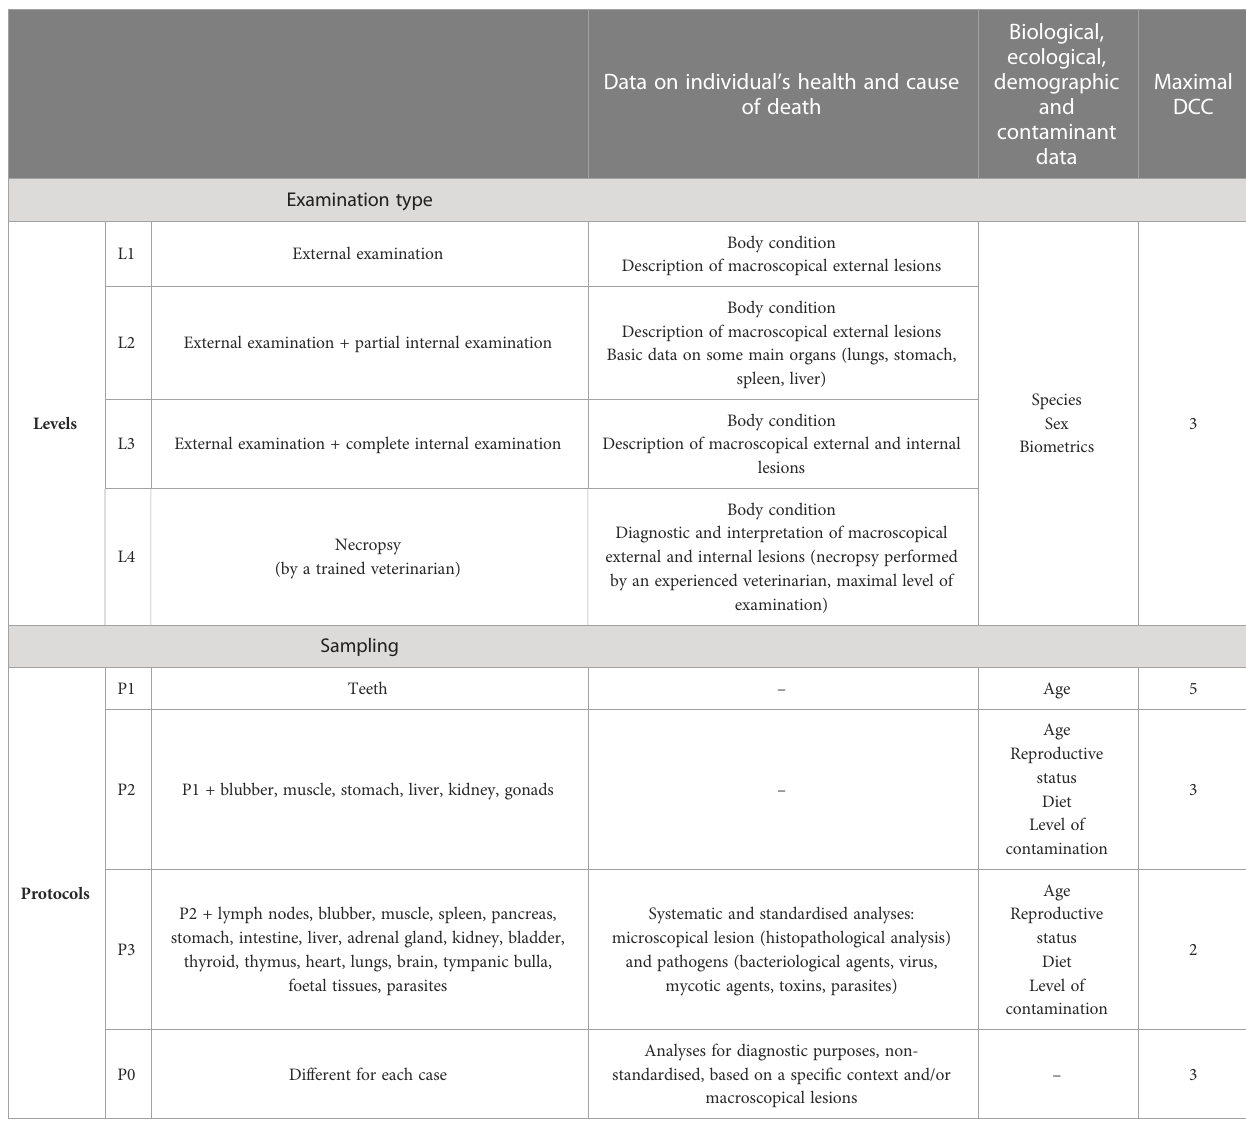
TABLE 1 Summary of the examination levels and sampling